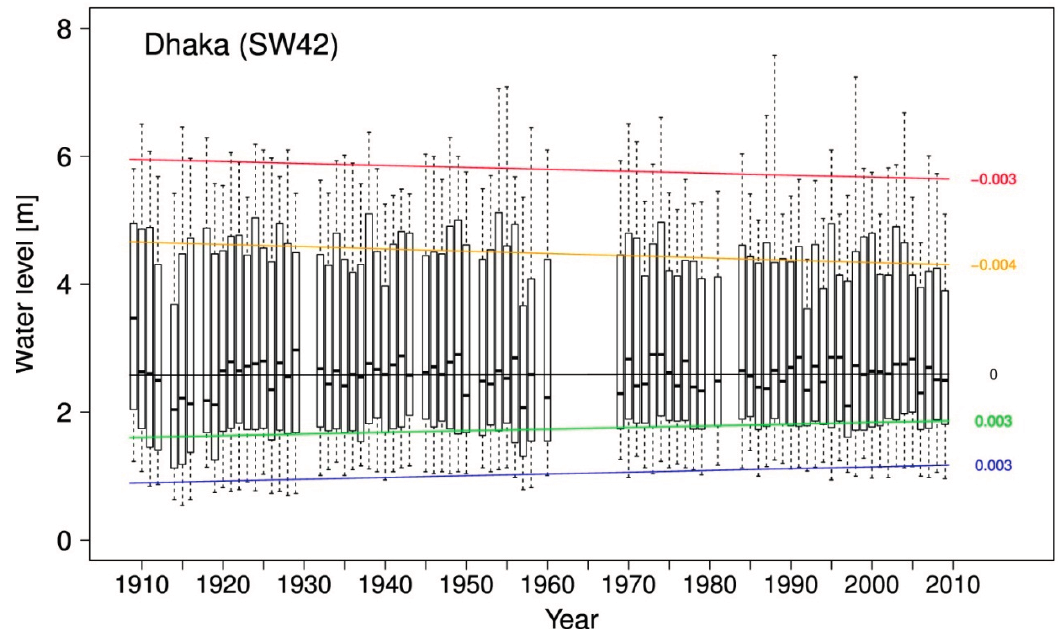
Figure 2. Annual boxplots for the water level station at Dhaka, 1909–2009. Regression lines are drawn through the upper and lower extremes (red and blue), as well as the 1st, 2nd, and 3rd quartile (green, black and orange, respectively). The slopes of the regression lines are printed on the right